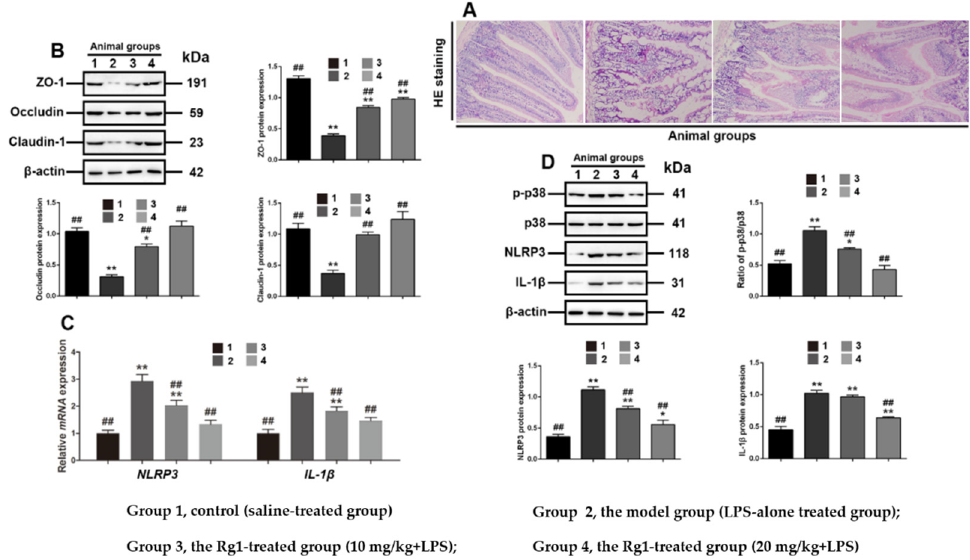
Figure 6. Rg1 inhibits tight junction disruption associated with interference with p38 MAPK signaling in murine intestinal dysfunction caused by LPS. Experimental groups including Group 1, control (saline-treated group); Group 2, the model group (LPS-alone-treated group); Group 3, the Rg1-treated group (10 mg/kg + LPS); and Group 4, the Rg1-treated group (20 mg/kg + LPS). Ileum sections were stained with HE for histological assessment. ( A ) Representative views are shown (original magnification × 20); ( B ) Western blot analyses of tight-junction-related proteins. Western blot analyses of tight-junction-related proteins; ( C ) mRNA level analyses of NLRP3 and IL-1 β ; ( D ) Western blot analyses of p38 MAPK signaling-related proteins. β -Actin was used as an invariant control for equal loading. Blots are representative of three independent experiments with densitometry showing the mean ± s.d. * p < 0.05 versus control and ** p < 0.01 versus control. # p < 0.05 versus LPS and ## p < 0.01 versus LPS.